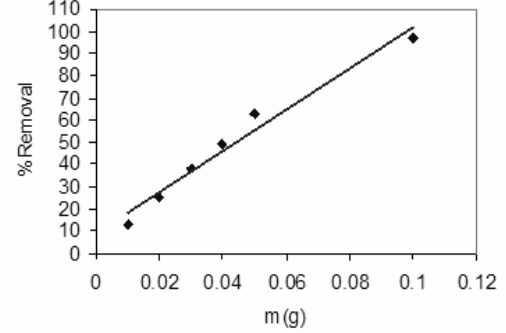
Figure 3 . The effect of sorbent dosage (PANi) on Pb 2+